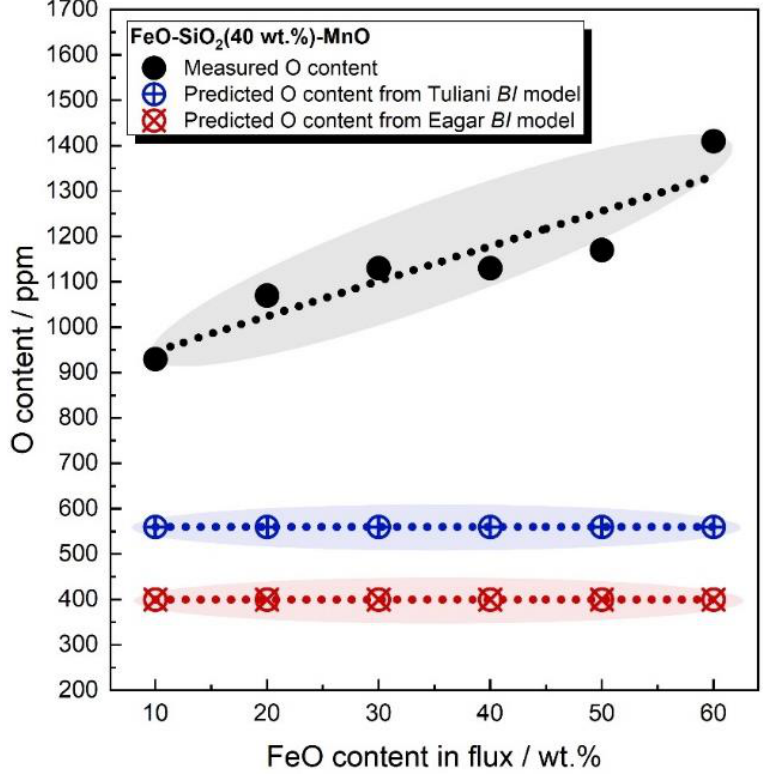
Figure 3. WM oxygen content as a function FeO content in flux.